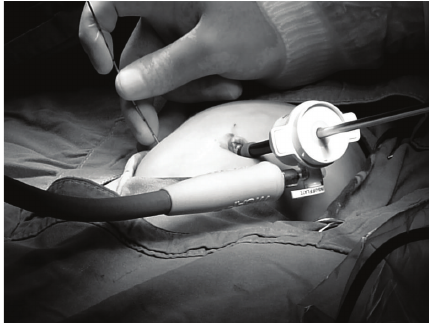
Figure 1: 5 mm umbilical trocar is introduced and Chiba needle is inserted percutaneously.